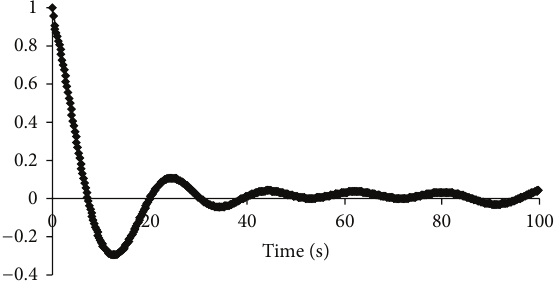
Figure 16: Correlation coefficient for 𝑤 for case